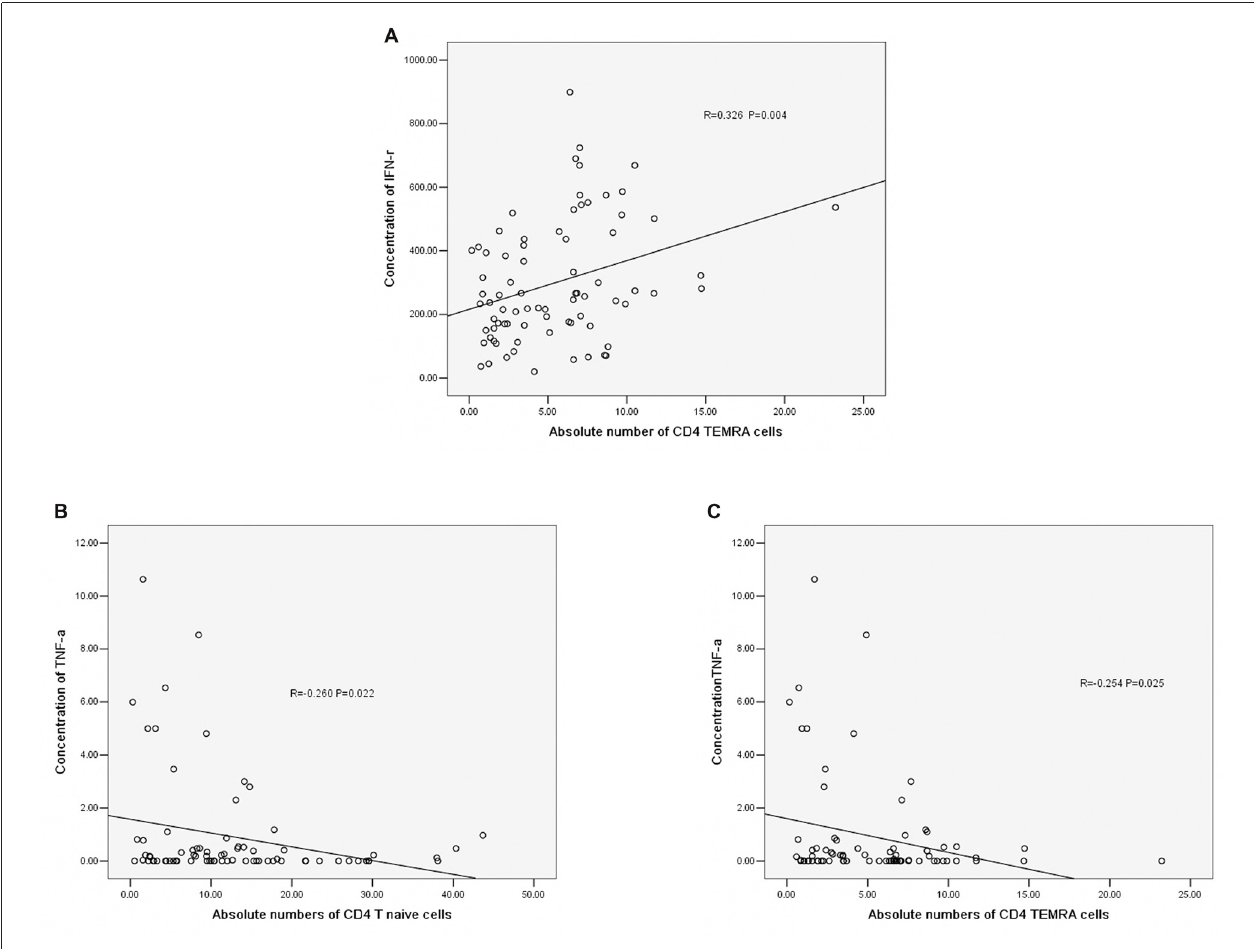
FIGURE 5 | (A) Correlation between IFN-r and the absolute number of CD4 + TEMRA cells. (B) Correlation between TNF- α and the absolute number of CD4 + T naïve cells. (C) Correlation between TNF- α and the absolute number of CD4 + TEMRA cells (correlation determined by Pearson correlation